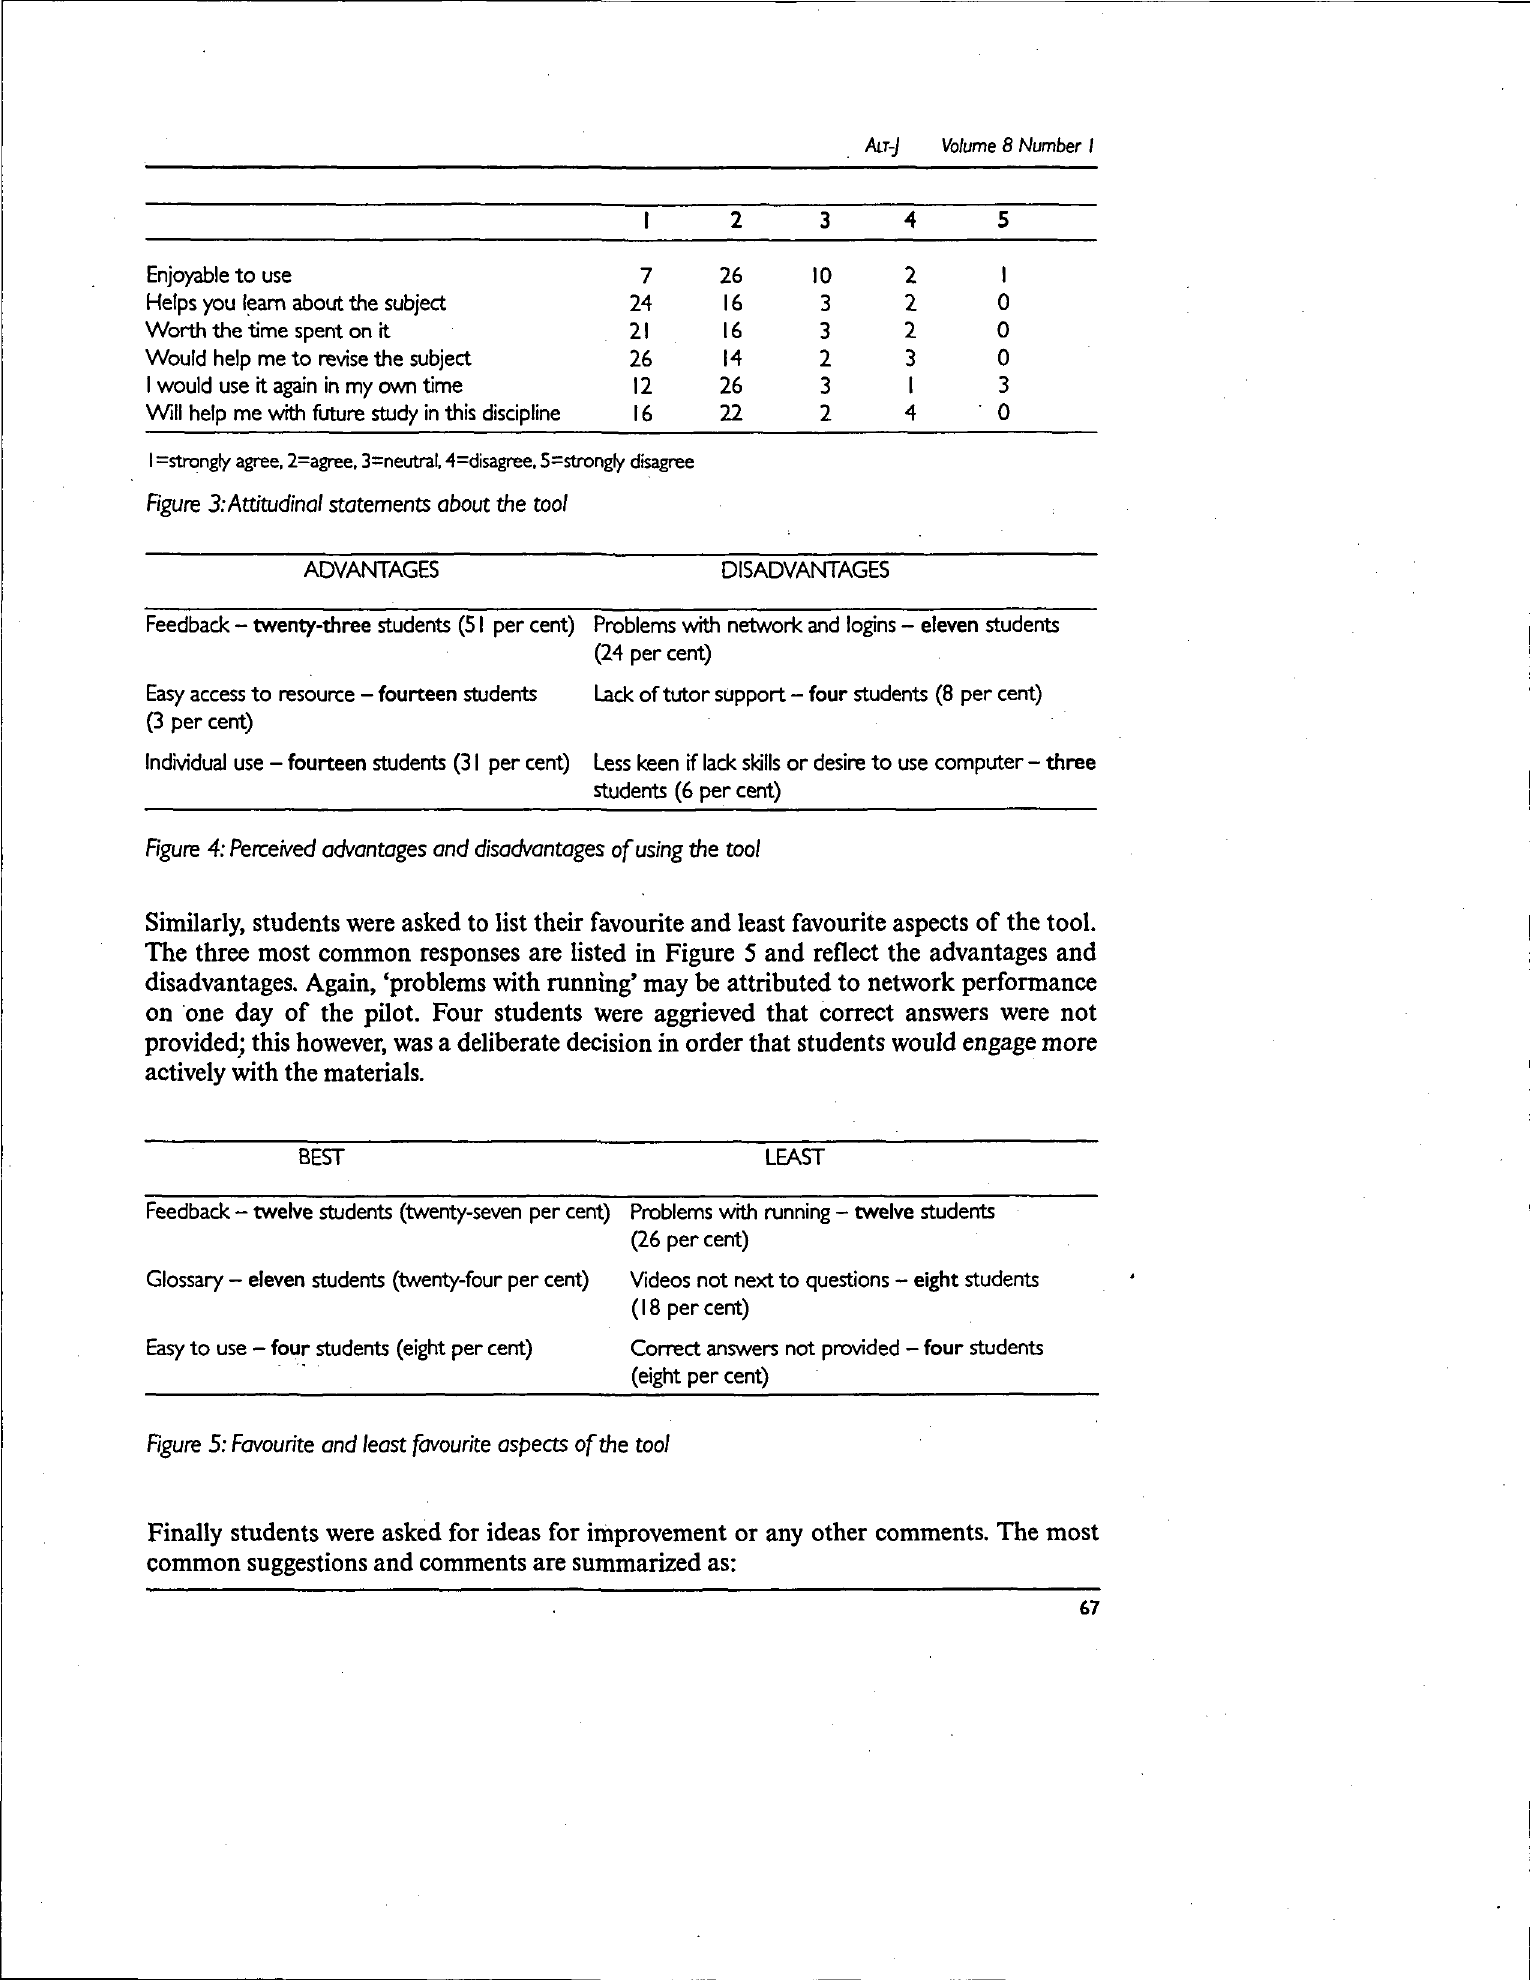
figure 3:Auitudmal statements about the tool